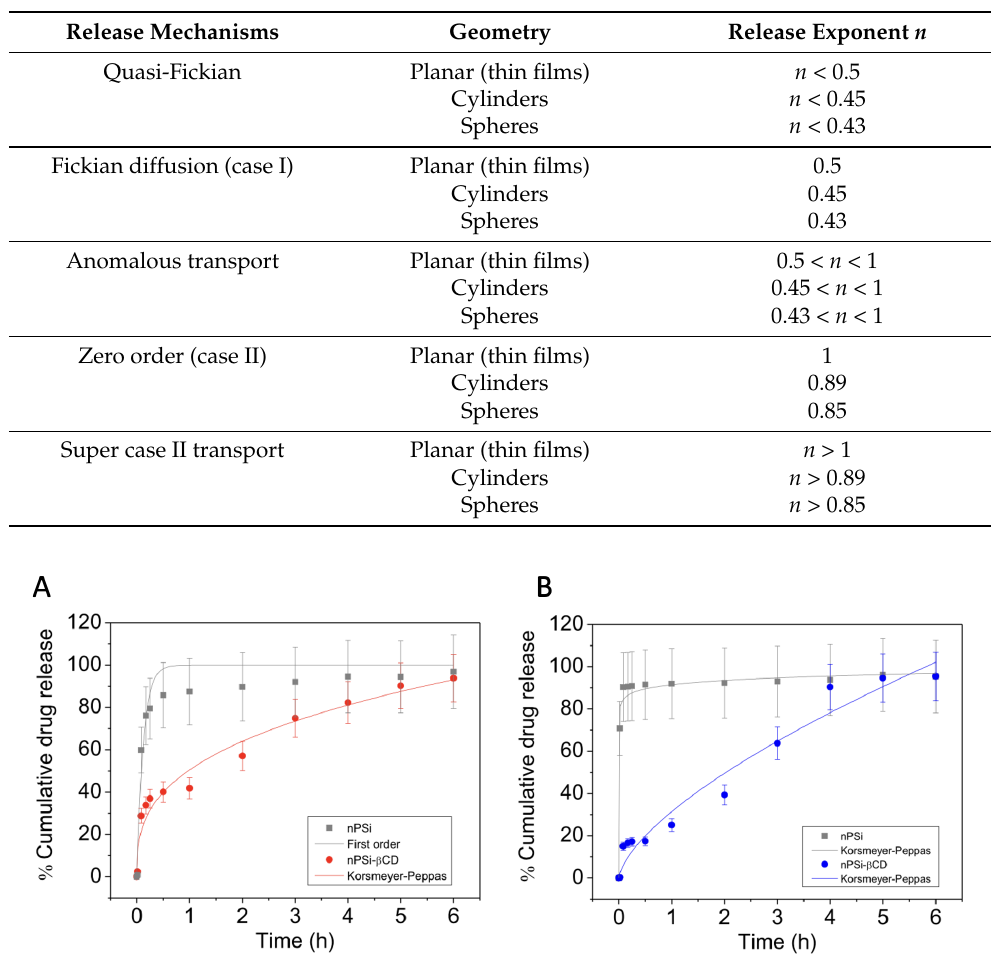
Table 6. Release mechanisms for different geometries according to the Korsmeyer–Peppas model.